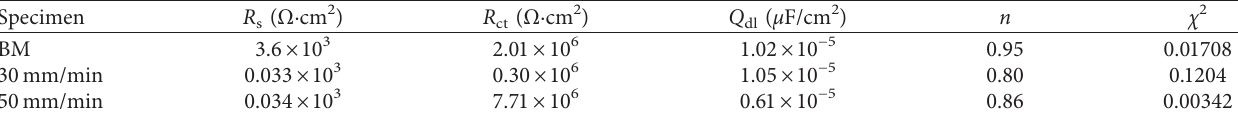
Figure 7: EIS results of base material and stir zones at different welding speeds: (a) Nyquist plots; (b) best equivalent circuit used to model the experimental EIS data. Table 3: Electrochemical corrosion parameters that resulted from analysis of Nyquist curves for specimens.